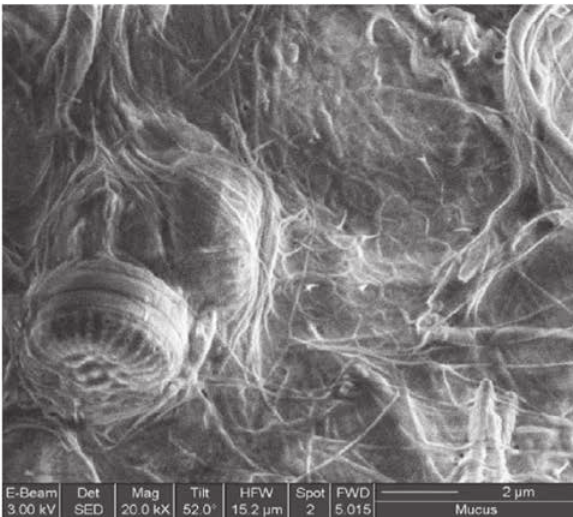
Faganeli in Malej: Obalni ekosistemi na prehodu: ...